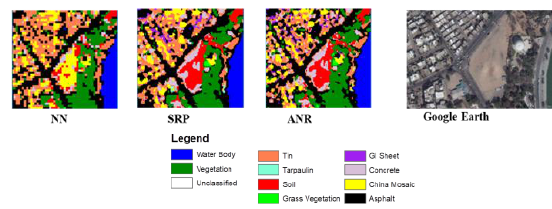
Figure 6. Visual Examination of SVM (RBF) Classified Outputs